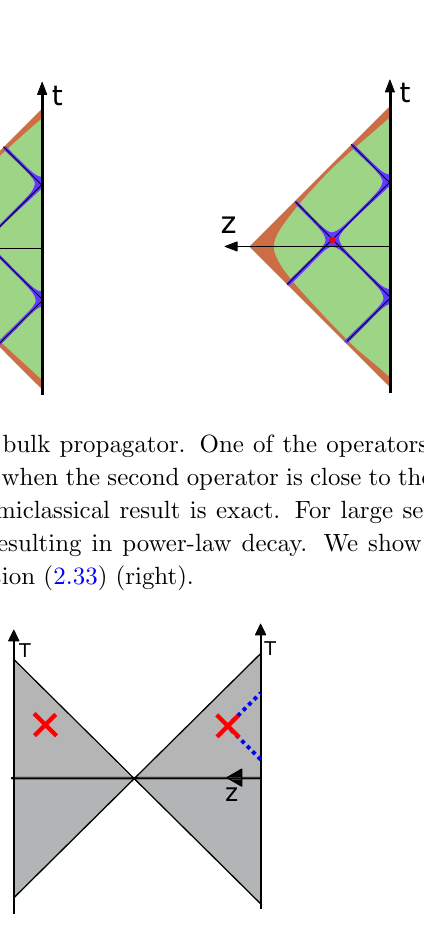
Figure 7 . Region of spacetime (gray) that can be reconstructed from the boundary using the radar construction of bulk points. Within the thermal ensemble, bulk operators can be taken to the other side by setting t i β t 2 − →